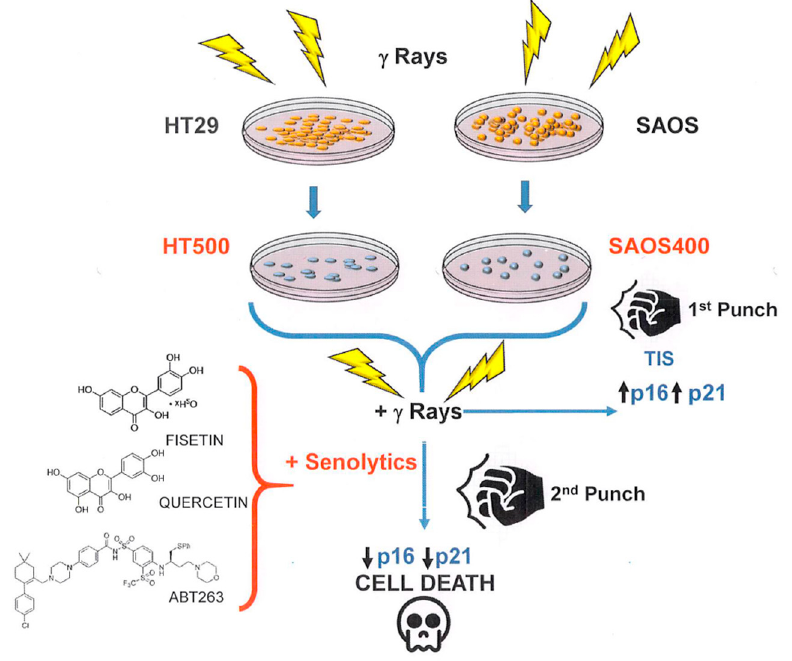
Figure 10. General cartoon showing how TIS can play the double role of a form of resistance to cell death but also as a process of “therapeutic vulnerability” for senolytic drugs.